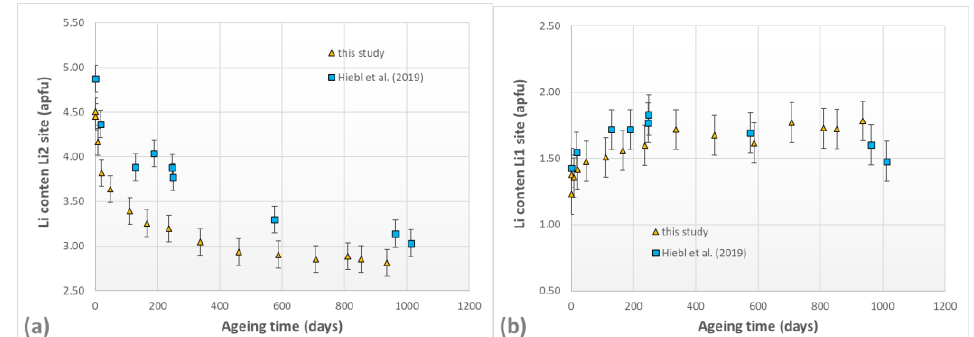
Figure 6. Variation of the Li-content at the Li1 ( a ) and Li2 ( b ) sites of Al10-LLZO during aging in a moist atmosphere. Note, the same crystal is used and remeasured.